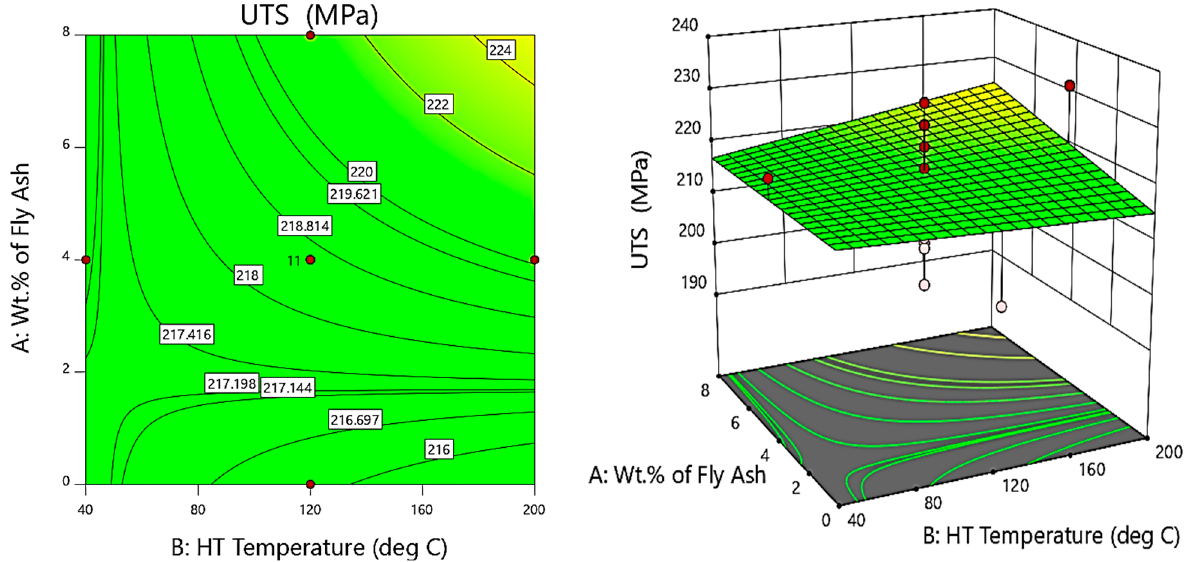
Figure 12. Contour and 3D surface plots for variation of UTS with varying wt.% of fly ash and HT temperature.